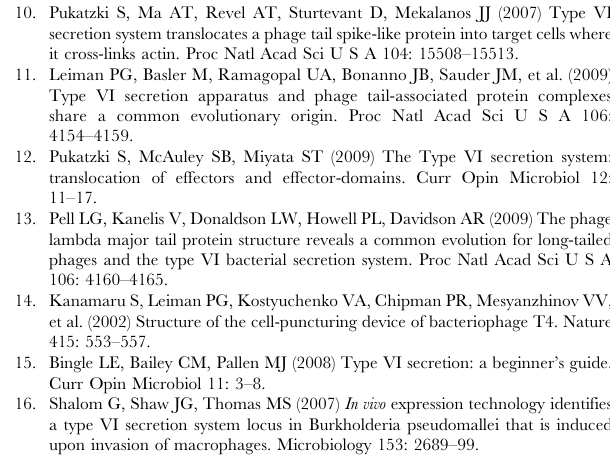
blue (N-terminus) to red (C-terminus); the sequence is represented above. Figure made with Pymol [61]. (TIF) Figure S6 Surface representation of TssJ. (A) TssJ B- factors. The surface is colored according to B-factors values, from blue (low B-factors) to red (high-B-factors). (B) TssJ electrostatic potential. The surface is colored according to the contact electrostatic potential calculated with Pymol [61]. Positively charged areas are shown in blue and negatively charged areas are in red. (JPG) Figure S7 Circular dichroism spectra of TssJ and TssM. (A) CD spectra of TssM-ekto (black line) and TssM-ekto-Nt (blue line). (B) Comparison of the Wild-type TssJ (TssJ wt; black line) compared to the loop depleted mutant (TssJ- D L1-2; red line). (TIF) Table S1 Biochemical characteristics of the proteins and domains reported in this work. Table S2 Biophysical characteristics of the proteins and domains reported in this work. Table S3 Data collection (PROXIMA 1 at SOLEIL) and refinement